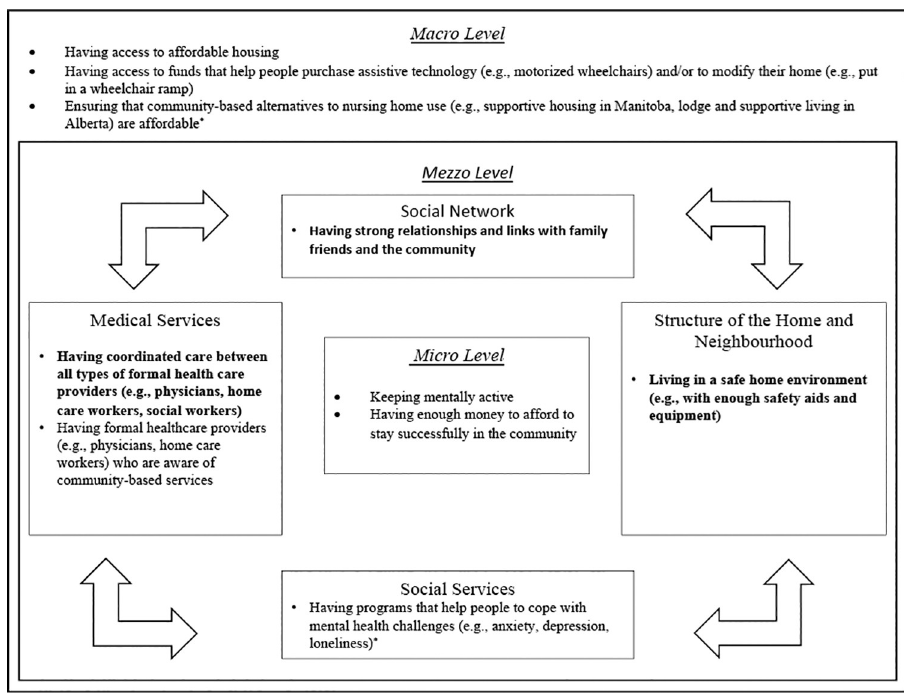
Fig 1. Consensus factors categorized using the Health-Related Safety Framework [54]. Bolded text: Consensus was reached by both groups; Un-bolded text: Consensus was reached by care partners only. � Factor was added after Delphi Round